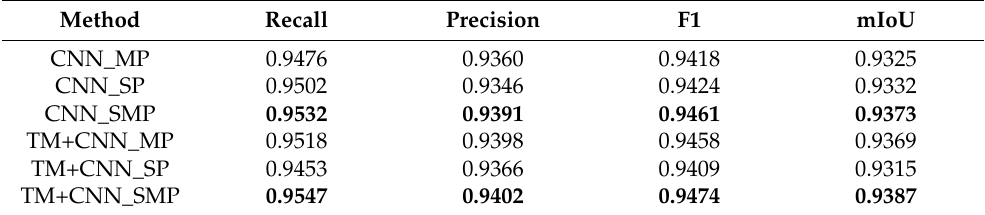
Table 6. Accuracy assessment of TRANet in terms of building extraction with different pooling modules. The highest accuracy is displayed in